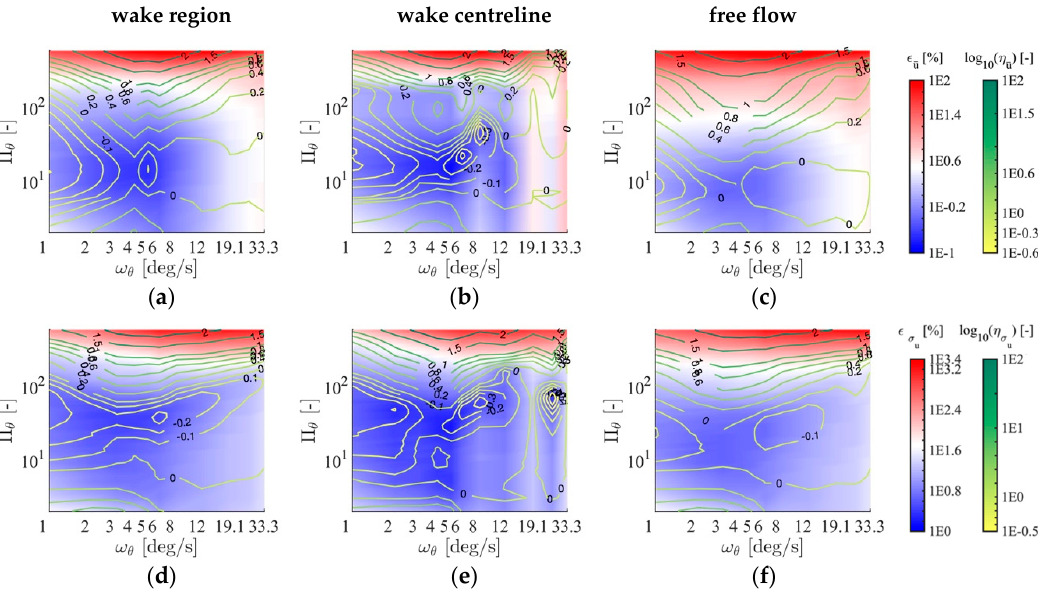
) for ( a , d ) wakes in the range of (cid:3296) u